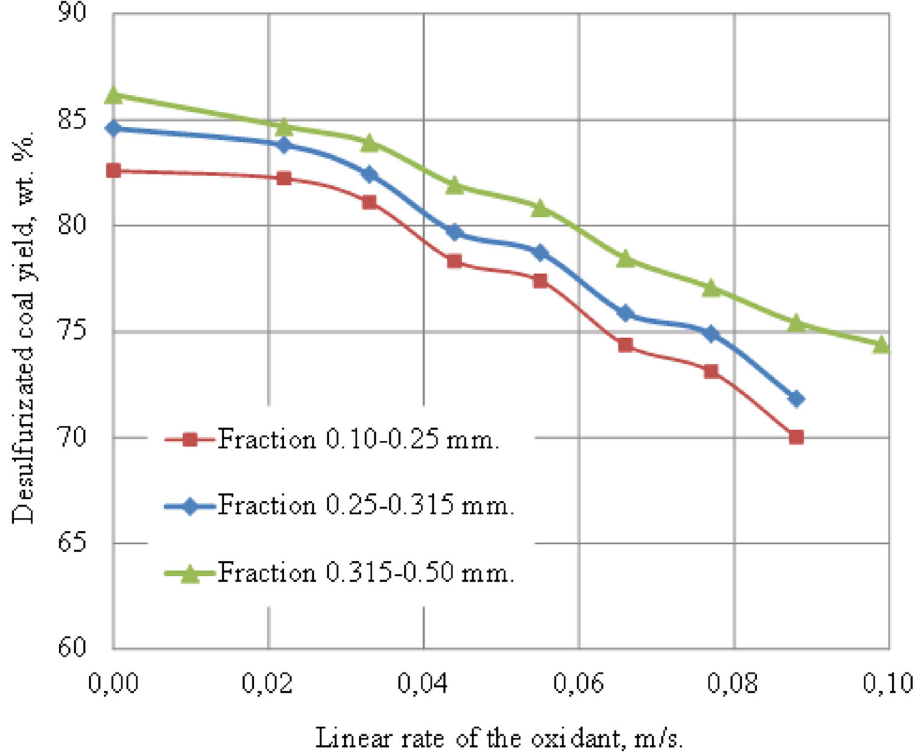
Fig. 2 Desulphurized coal yield versus OLV and coal particles’